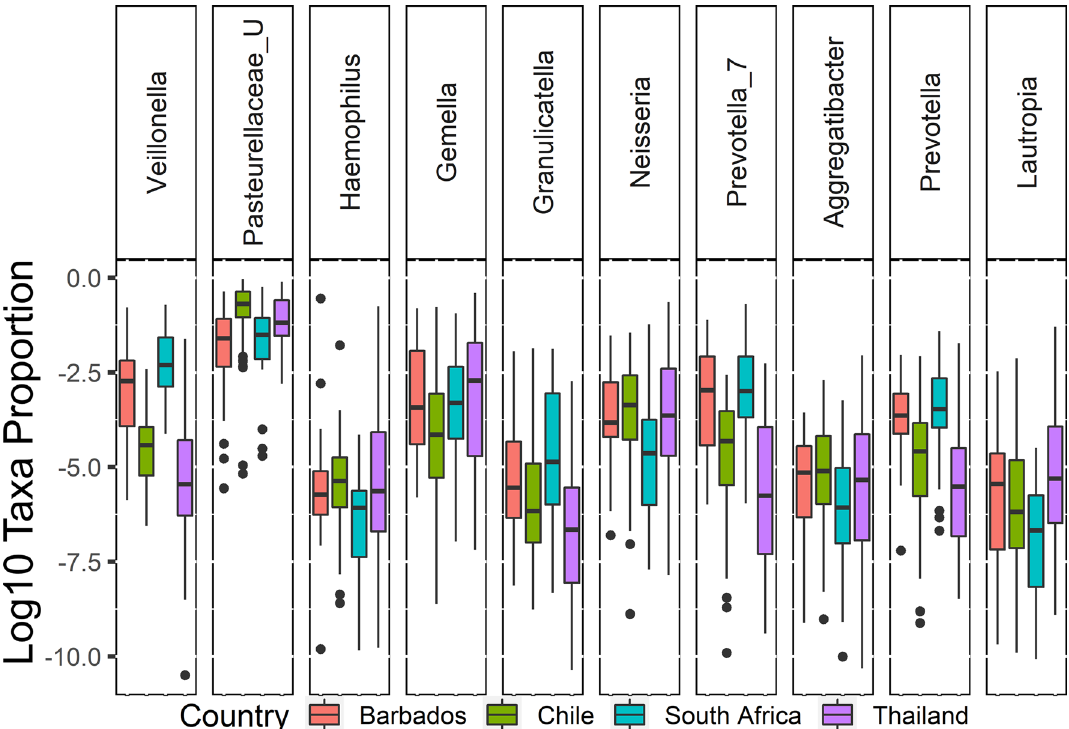
Figure 4. Box and whisker plot showing the significant differential abundant cheek genera between four countries.